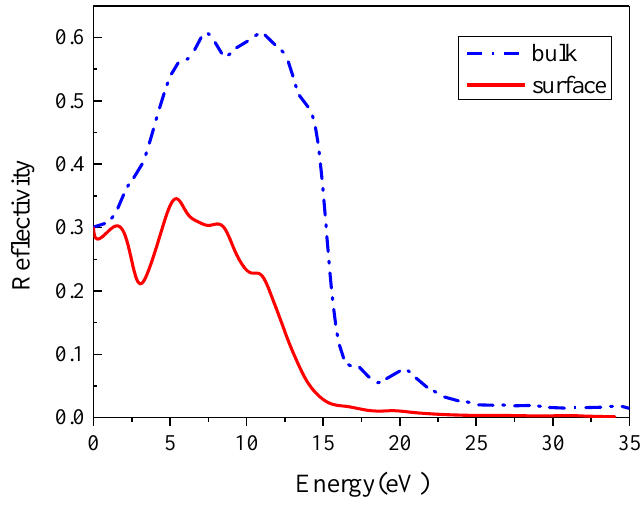
Figure 6. Reflection spectrum of In 0.87 Ga 0.13 As 0.25 P 0.75 bulk and surface.